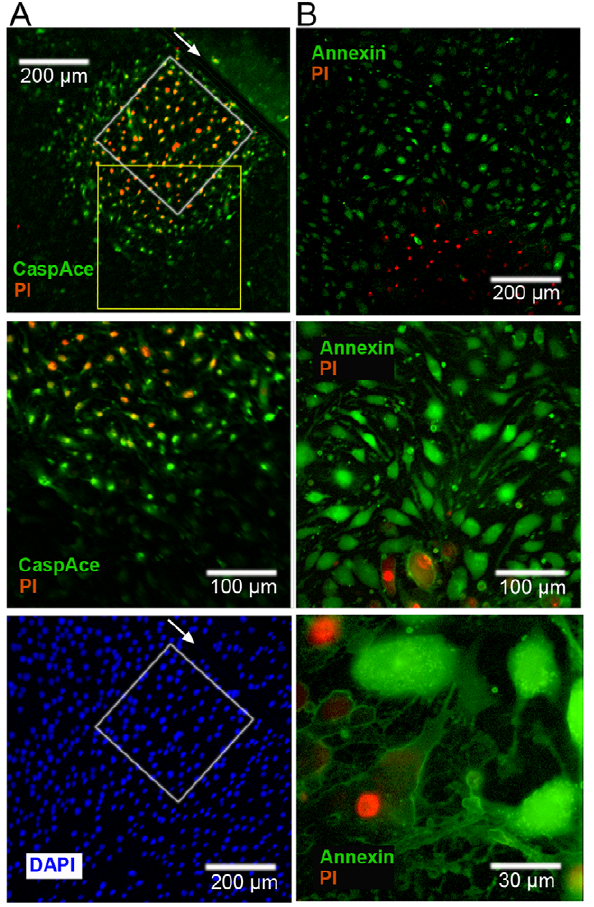
Figure 6. Apoptotic cell death in bystander cells following COI. A – bEnd.3 monolayers were linearly scratched by a surgical scalpel (arrow), subjected to COI (white rectangle, left of scratch upper panel) and placed back in the incubator for 3h. Then, CaspACE FITC-VAD-FMK, PI and DAPI were added to the cells. Upper and lower panels are snapshots of the same field of view. Middle panel is a higher magnification snapshot of the yellow rectangle in upper panel. Cell death (PI + ) is preceded by CaspACE staining at 100–200 m m beyond the COI, left of the scratch only. B – bEnd.3 monolayers were placed in the incubator after COI for 3h, and then subjected to Annexin-V-FITC (for phosphatidylserine depolarization) and PI. Phosphatidylserine depolar- ization ((Annexin-V) + cells (green)) clearly precedes cell death and permeabilization (PI + ). Panels show different magnifications. Images are a representative of n=3 experiments.